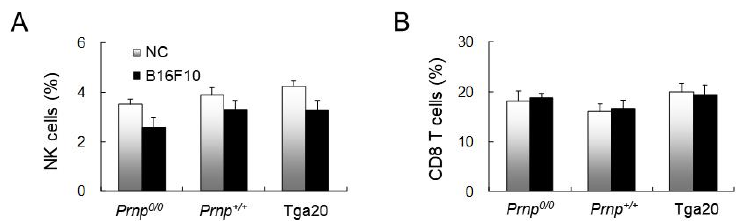
Figure 4. Flow cytometric analysis of cancer-related cells in the spleens of the negative control (NC) and B16F10-treated groups at the terminal stage of lung cancer. ( A ) DX5 + NK cells (%). ( B ) CD3 + CD8 + cells (%). Data are for an average of 12 mice per group. Error bars represent mean values ± standard deviation.